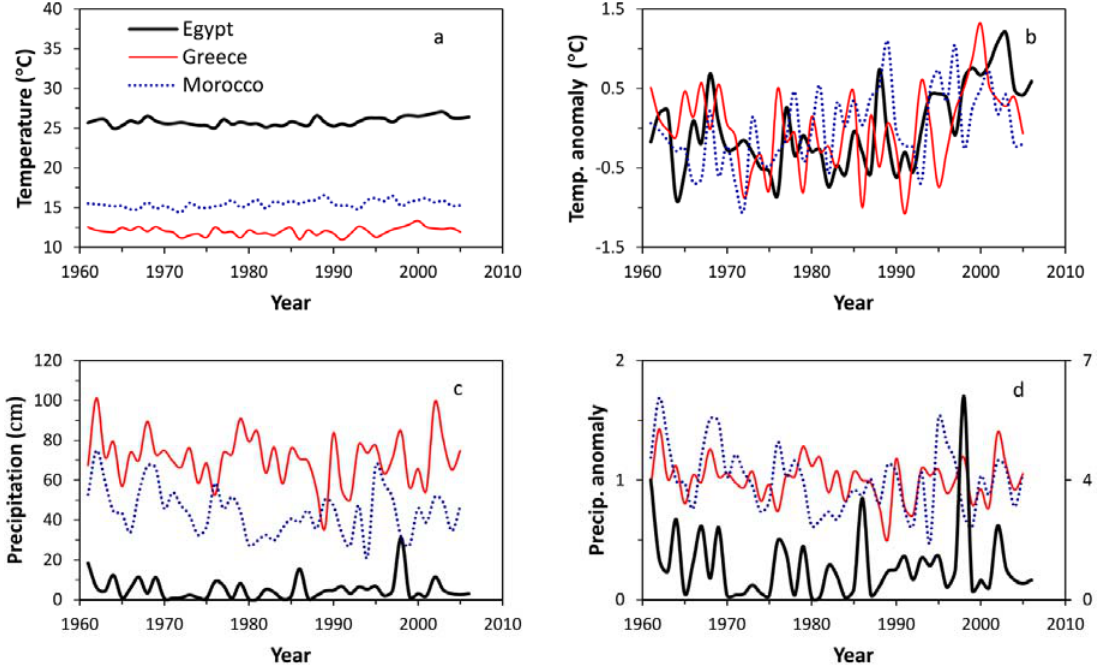
Figure 4. Annual variation of average temperature ( a ) and its anomalies ( b ) along with annual variation of total precipitation ( c ) and its anomalies ( d ), during the growing season between 1961 and 2006 in Egypt, Greece and Morocco. Temperature anomalies were calculated as the difference between current and average values, while precipitation anomalies were calculated as the ratio between current and average values. Precipitation anomalies are shown on the primary y -axis for Greece and Morocco, and on the secondary y -axis for Egypt.